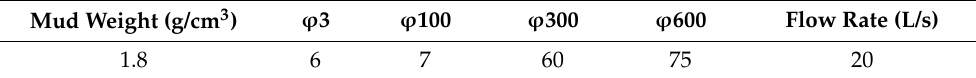
Table 9. Drilling fluid performance and drilling parameters for well